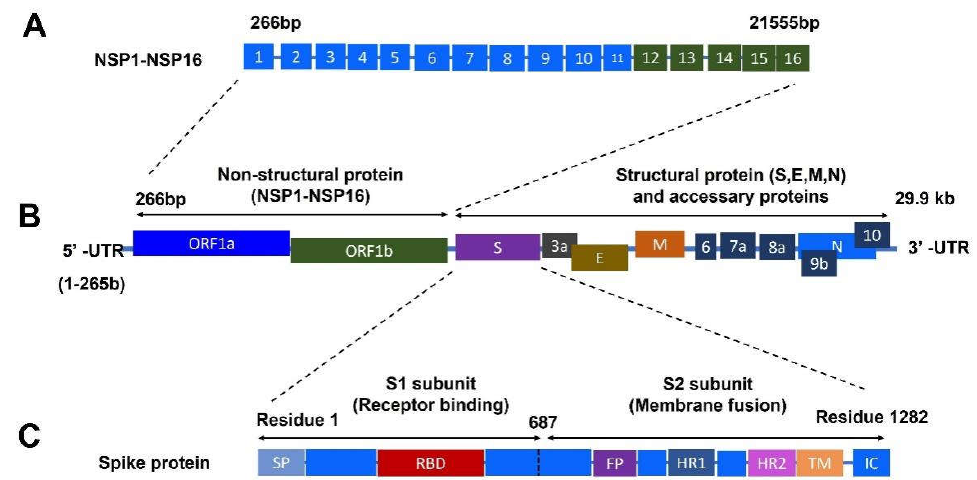
Figure 1. A schematic graphic of the genome-encoded proteins of SARS-CoV-2. ( A ) Genome-encoded nonstructural proteins from NSP1 to NSP16. ( B ) Genome-encoding proteins of SARS-CoV-2 with the structural proteins and nonstructural proteins. ( C ) Full length of S protein of SARS-CoV-2 comprised of subunit 1 (S1) and subunit 2 (S2). Abbreviations: bp: base pair; E: envelop protein; FP: fusion peptide; HR1 and HR2: heptad repeat regions 1 and 2; IC: intracellular tail; kb: kilobase pair; M: membrane protein; NSP: nonstructural protein; N: nucleocapsid protein; ORF1a: open reading frames 1a; ORF1b: open reading frames 1b; RBD: receptor-binding domain; S: spike protein; SP: signal peptide; S1: receptor-binding subunit; S2: membrane fusion subunit; TM: transmembrane; 5′-UTR: 5′-untranslated region; 3′-UTR: 3′-untranslated region.